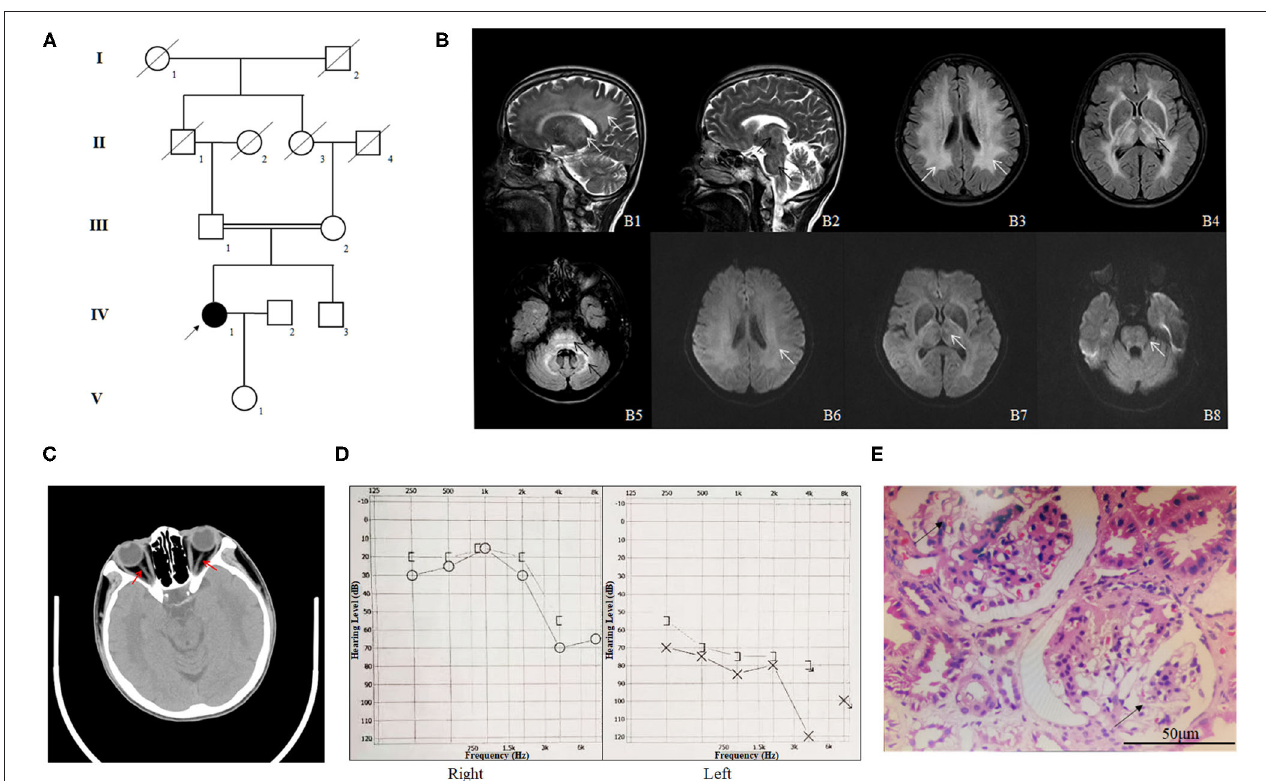
FIGURE 1 | The clinical profile of the family. (A) Pedigree of the phospholipase D3 (PLD3)-deficient family. The pedigree chart shows five generations of the family. Roman numerals refer to generations. Circles refer to female subjects. Squares refer to male subjects. Solid symbols refer to affected subjects. Crossed-out symbols refer to deceased subjects. The arrow indicates the proband. (B) The MR images of the proband. T2 image shows high intensity of white matter and thalamus ( B1 , white arrows), high intensity of brain stem and thalamus ( B2 , black arrows), high intensity of bilateral white matter ( B3 , white arrows), high intensity of bilateral thalamus ( B4 , black arrows), and high intensity of brain stem and bilateral cerebellum ( B5 , black arrows). B6–8 are the diffusion weighted image (DWI) corresponding to B3–5 and shows slightly higher intensity. (C) The CT image of the proband indicating tapering of bilateral optic nerves (red arrows). (D) Pure-tone audiometry (PTA) results of the proband. (E) HE staining of the renal biopsy specimen of the proband (IV-1); the arrows indicate glomerulosclerosis.